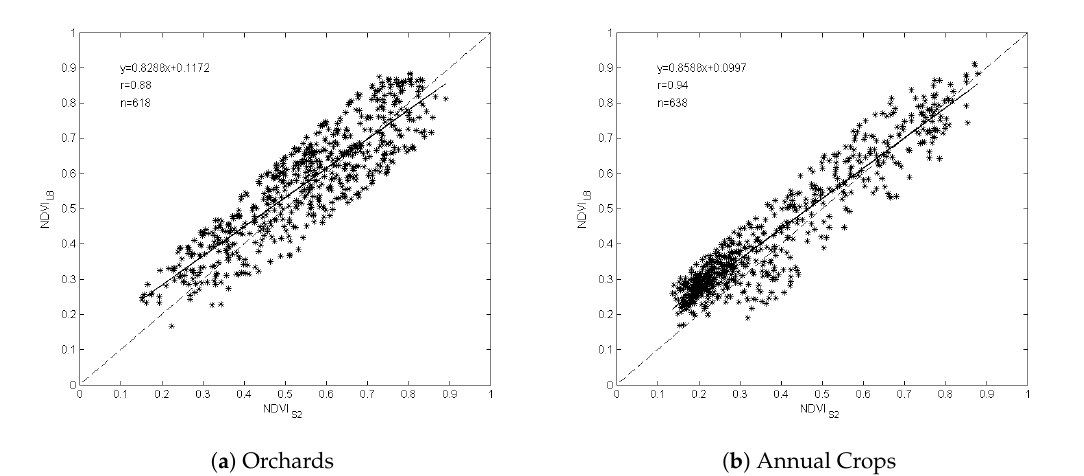
Figure 4. Scatter graph between NDVI S 2 and NDVI L 8 for: ( a ) orchards and ( b ) annual crop agricultural covers. The dashed line is 1:1 and the solid line corresponds to the linear least squares fitting.